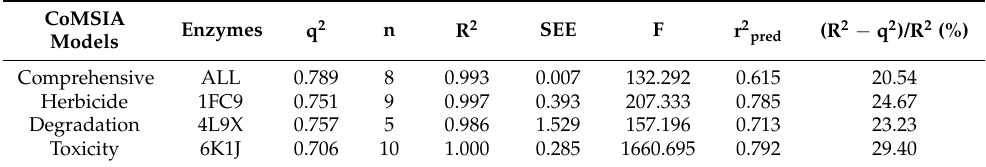
Table 1. CoMSIA model evaluation parameters for the herbicidal functionality properties, degradability, and toxicity of S-THs and their comprehensive effects.